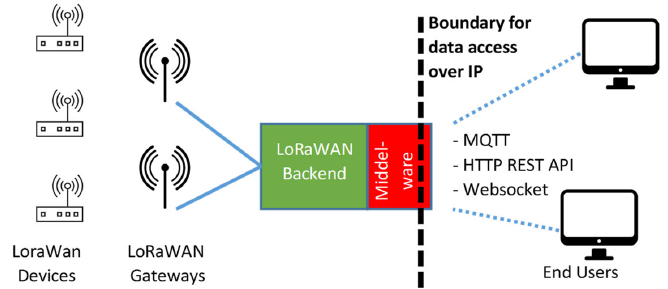
Figure 1. Block diagram of a regular LoRaWAN solution, where a wireless tier is connected to the wired tier (the backend) via GWs. In this case, the middleware providing integration with the end users marks the boundary where data are accessible over the IP protocol.